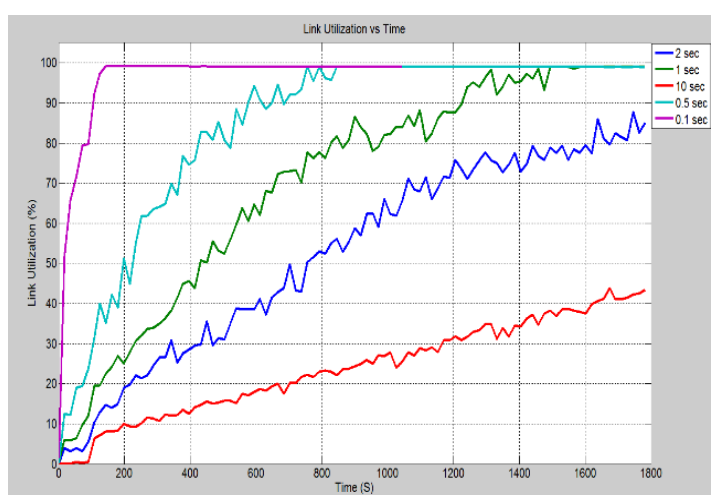
Figure 17. Case 4: CPU Utilization rate (%) for different inter arrival time.